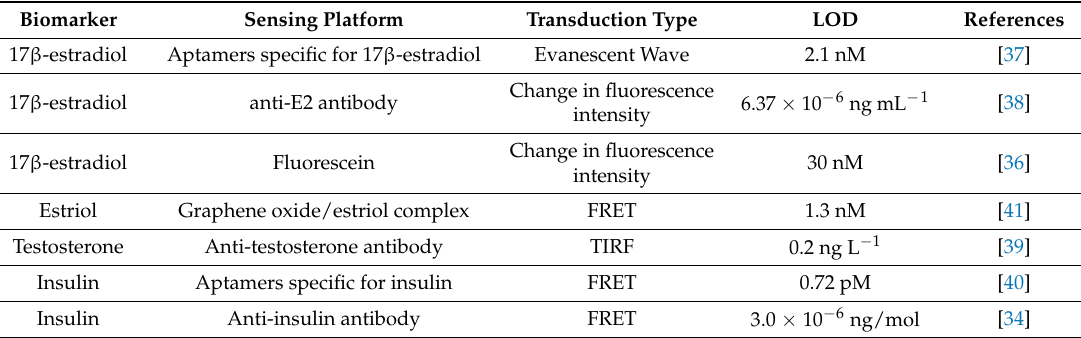
Table 1. Fluorescence-based biosensors for hormones